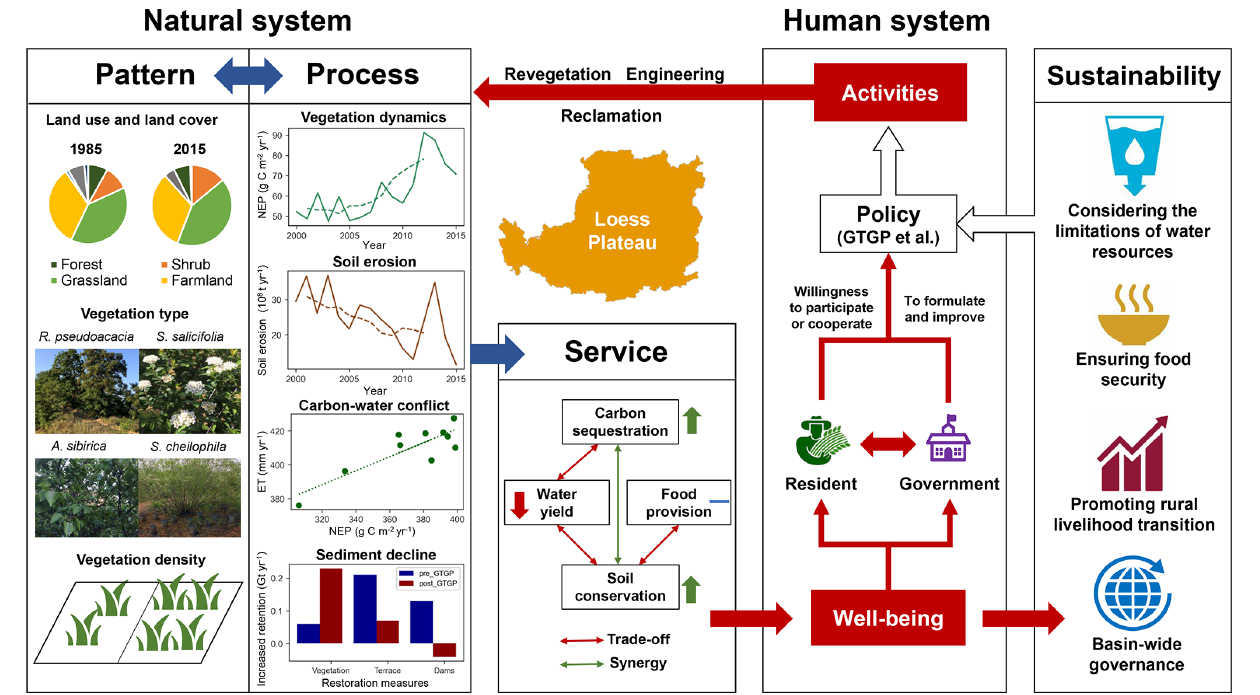
Figure 3. Illustration of the coupled human and natural system studies of China’s Loess Plateau using the pattern–process–service– sustainability framework. Data used in this figure were obtained from Wang et al. (2016), Feng et al. (2016), Liu et al. (2019), and Wu et al.